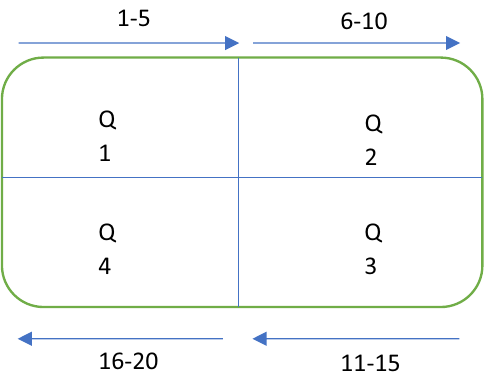
Figure 4. Sequences of surface testing.